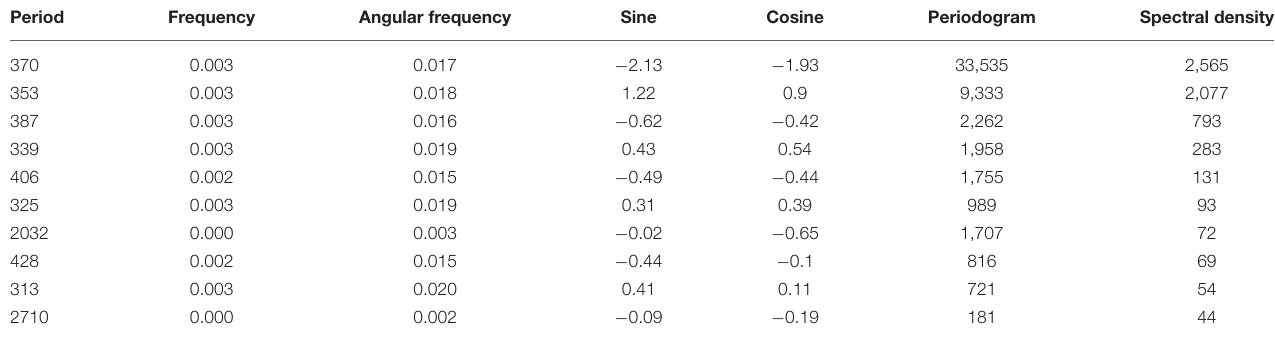
TABLE 2 | Subset of harmonics.